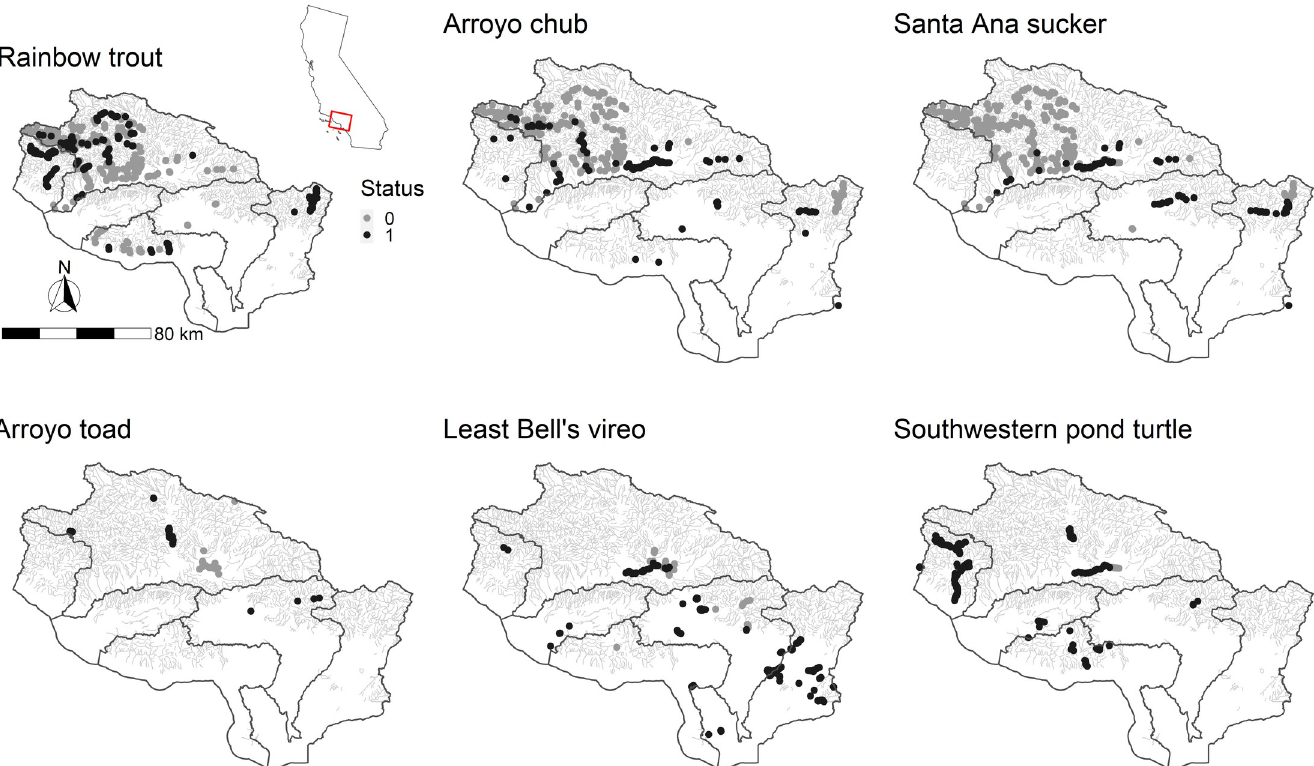
Fig 1. Study region with inset map showing location within California, USA, in the top left panel. The flow lines shown are included in this analysis. Blank watershed spaces are areas with heavily altered streams and not included in this analysis. Points represent the observed species data obtained for the study region. Each point represents a unique survey. Grey points denote species absence and black points denote species presence. Note: If a species observation point is shown in areas where there is no flowline, they are occurring along altered streams reaches and not included in this analysis unless a flow gauge is present in that stream reach. Flow line source: USGS national hydrography dataset (NHD,